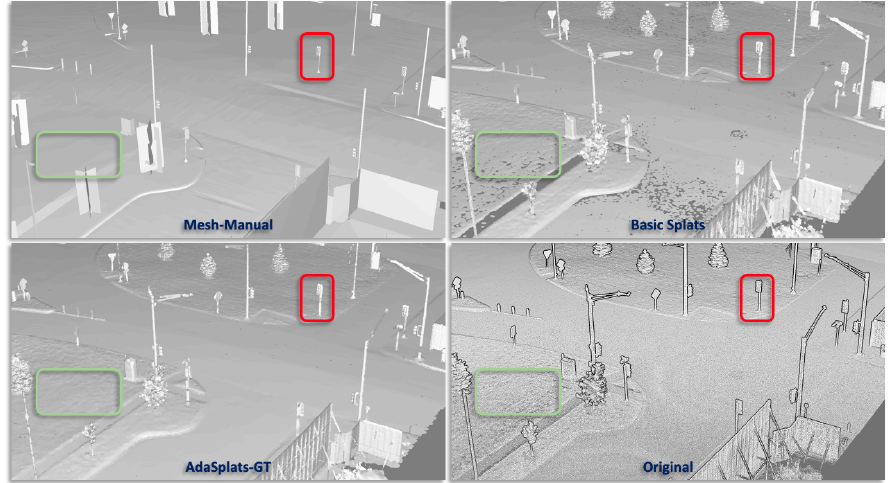
Figure 12. Rendering the different surface representations on M-City. The top row shows the manually meshed scene ( left ) and basic splats ( right ). The bottom row shows the results of rendering AdaSplats using GT semantics ( left ) and the original point cloud ( right ).